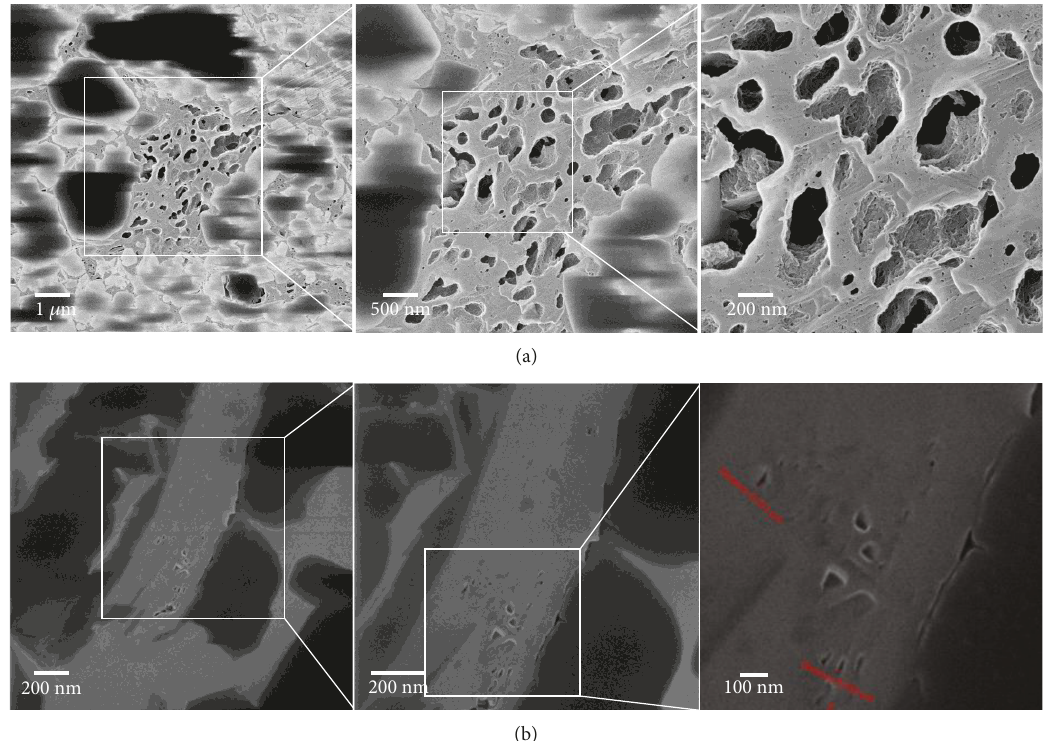
Figure 12: FIB-HIM photos of organic-rich shale: (a) the lower Silurian Longmaxi shale in Jiaoye-1, Jiaoshiba Play (depth: 2402 m, TOC: 4.44%, R o : 2.58%) (from Wang et al. [13]) and (b) the lower Silurian Wangyinpu shale in Jiangye-1, Xiuwu Basin (depth: 2402m, TOC: 11.27%, R o : 3.8%). See Figure 1 for the well